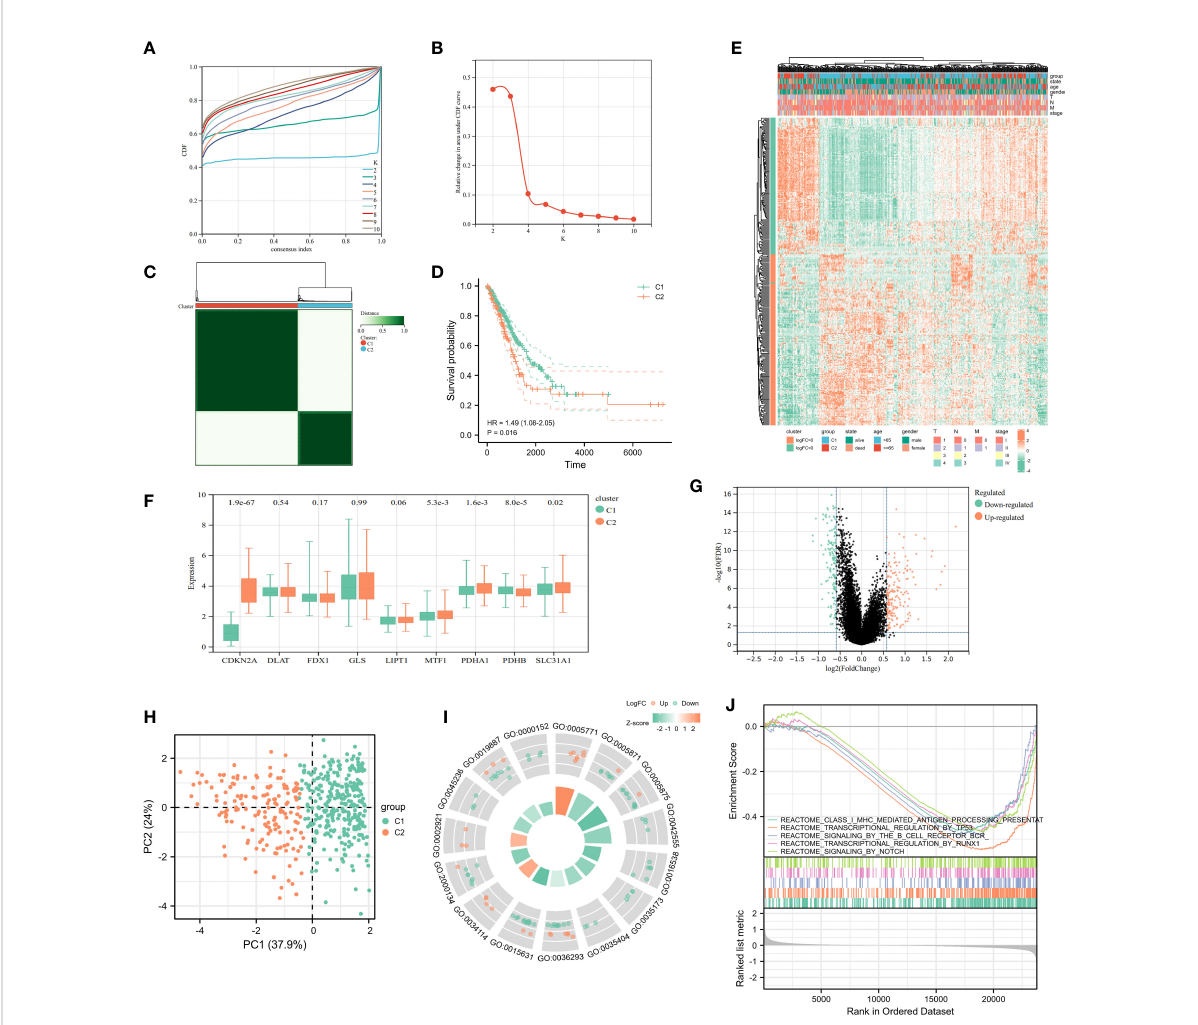
FIGURE 3 Characteristics of Cuproptosis-related Cluster in TCGA-LUAD cohort. (A) Delta area curve of consensus clustering indicated the relative change in area under the cumulative distribution function (CDF) curve from k = 2 to 10. (B) The intragroup correlations were the highest and the inter- group correlations were low when k = 2. (C) Cluster diagram for consensus clustering analysis (k = 2) of cuproptosis-related genes in 442 LUAD samples in TCGA. (D) Kaplan-Meier curve showed survival probability of cluster1 and cluster2. (E) The heatmap showed the relationship between clinical features and the expression of cuproptosis-related genes in two clusters. (F) The expression of 9 cuproptosis-related genes in two clusters. (G) The volcano plot showed the different expression of genes between the two clusters. (H) PCA analysis for the two clusters. The most signi fi cant GO enrichment (I) and multiple pathways by GSEA enrichment analysis (J) in two